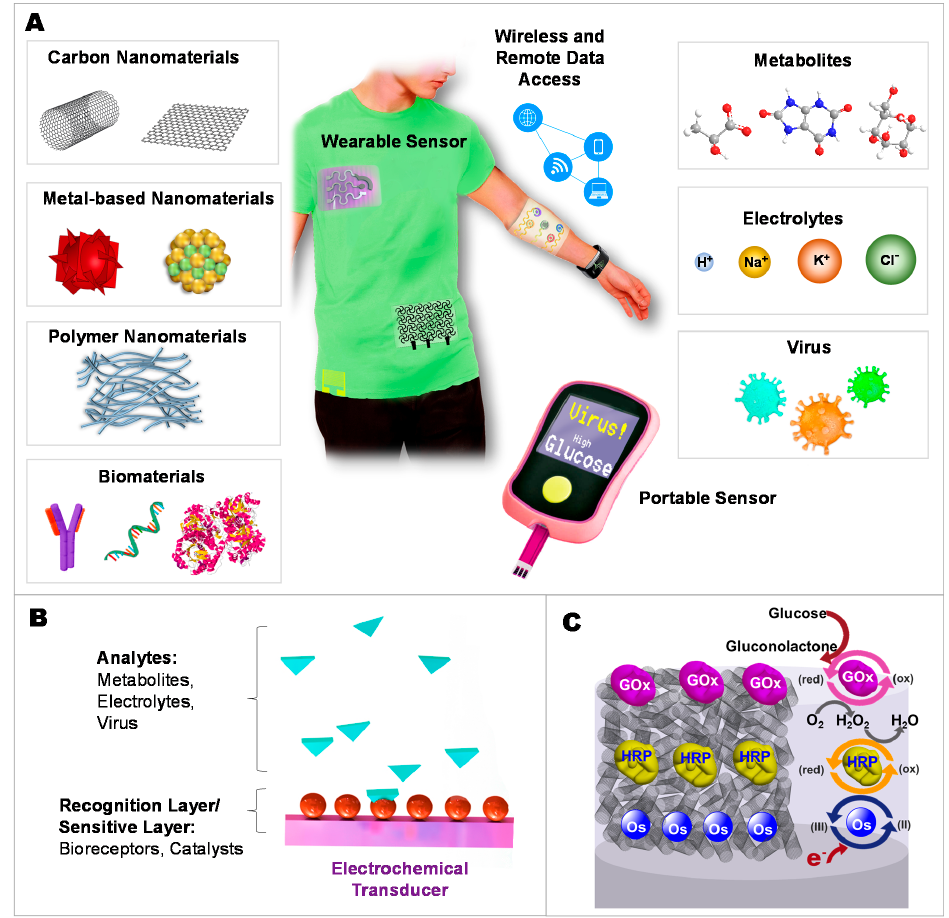
Figure 1. Concepts of out-of-clinic electrochemical biosensors. ( A ) The main platforms include